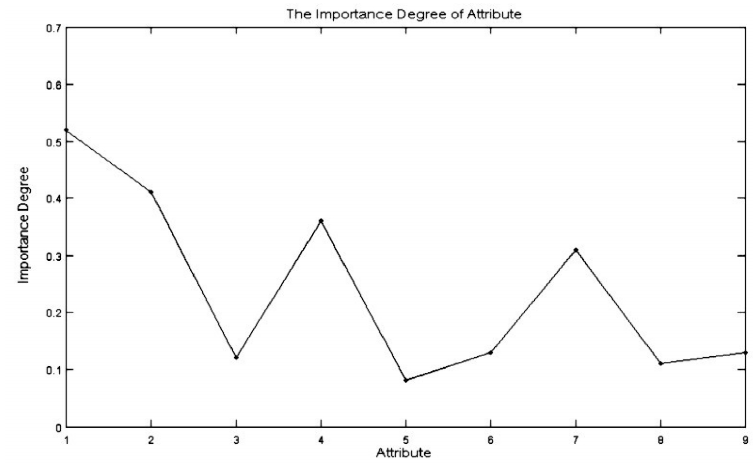
Figure 2. The Importance Degree of